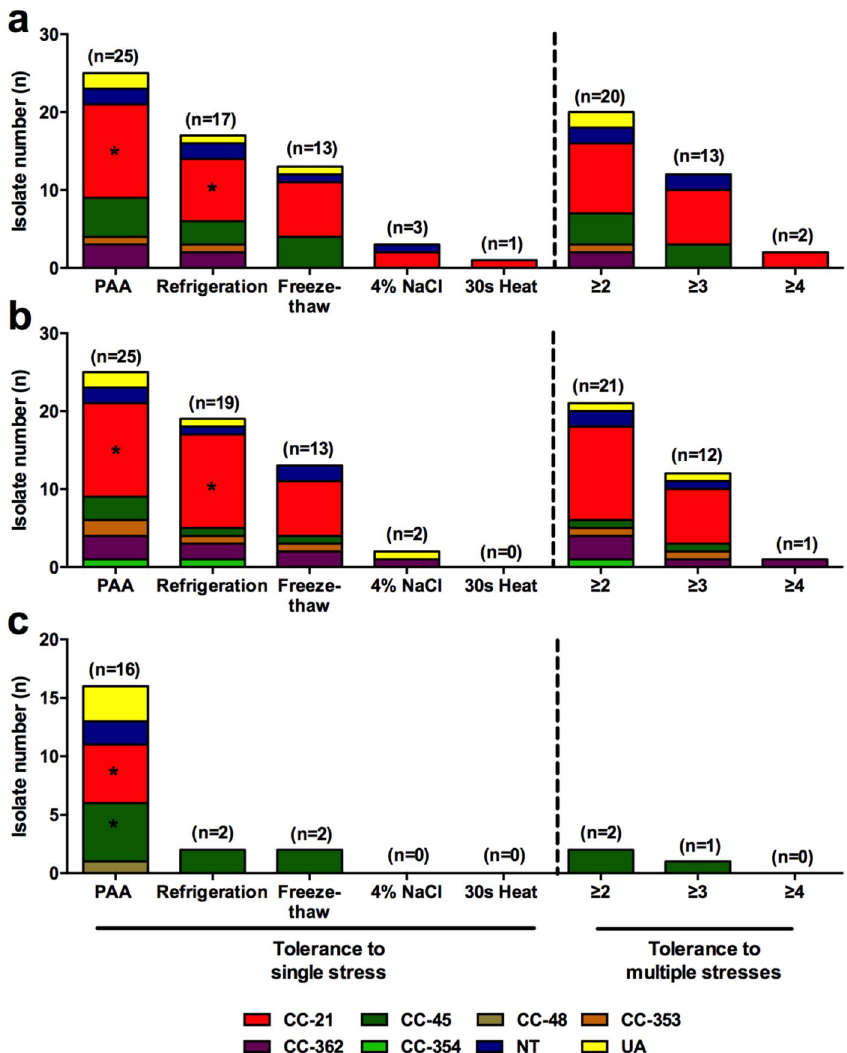
Figure 6. MLST clonal complexes of HAT ( a ), AT ( b ), and OS ( c ) strains of C . jejuni tolerant to stress conditions. Statistical significance was determined using two-way ANOVA. * P <